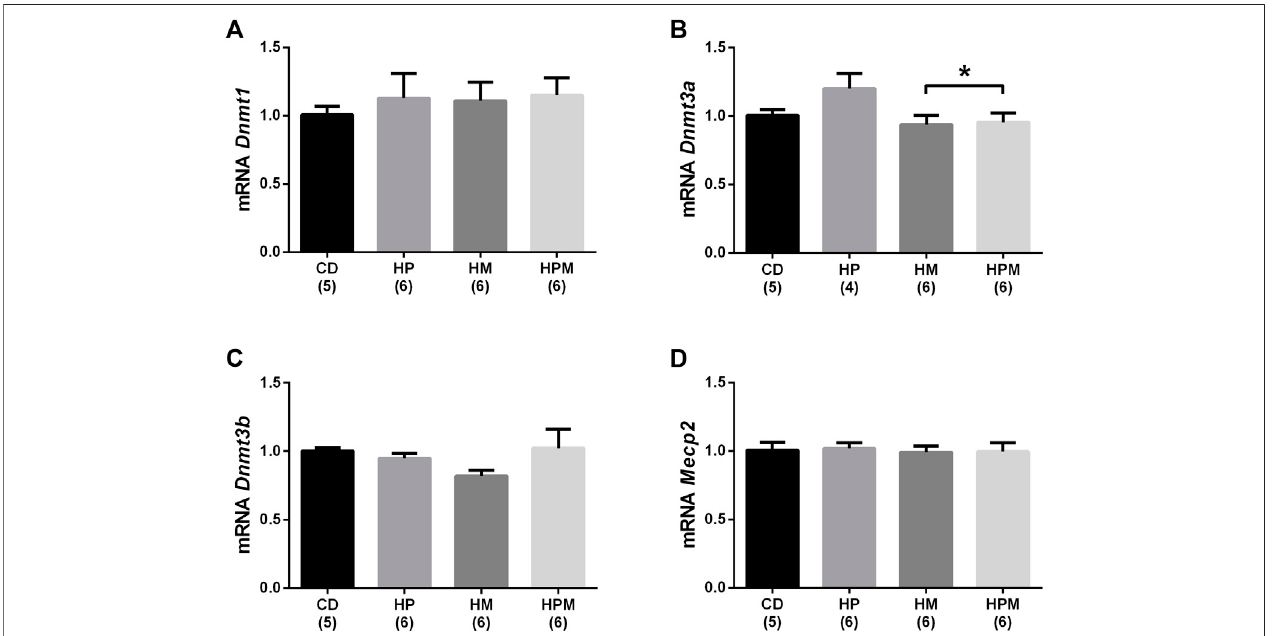
FIGURE3 | Testicular gene expression ofepigenetic markers in male rat offspring from progenitorsfed on high-fat high-sugar diet.Mean ± SEM; symbolsindicate signi fi cant difference caused by parental diet ( p < 0.05): *statistically signi fi cant by the effect of maternal diet. H: high-fat and high-sugar diet; CD (control paternal and maternal diet), HP (H paternal diet and control maternal diet), HM (H maternal diet and control paternal diet) and HPM (H paternal and maternal diet). (A) : DNA methyltransferase 1 ( Dnmt1 ) ( n = 5-6); (B) : DNA methyltransferase 3a ( Dnmt3a ) ( n = 4-6); (C) : DNA methyltransferase 3b ( Dnmt3b ) ( n = 5-6); (D) : methyl CpG binding protein 2 ( Mecp2 ) ( n = 5-6).